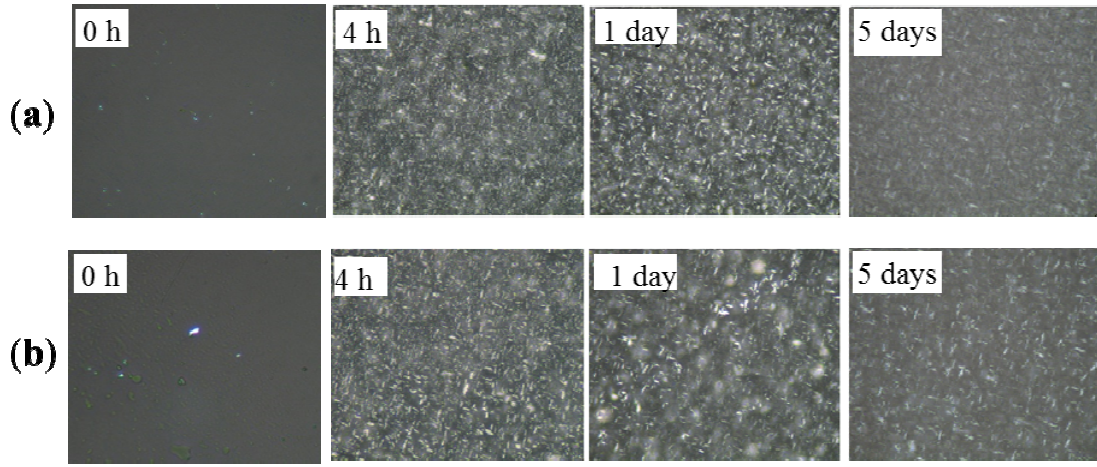
Figure 3. Polarized light photomicrographs for the PS/PO oil blends under 120 MPa HPM treatment: ( a ) Treated once and crystallized 0 h, 4 h, 1 day and 5 days. ( b ) Treated twice and crystallized 0 h, 4 h, 1 day and 5 days respectively. Magnification